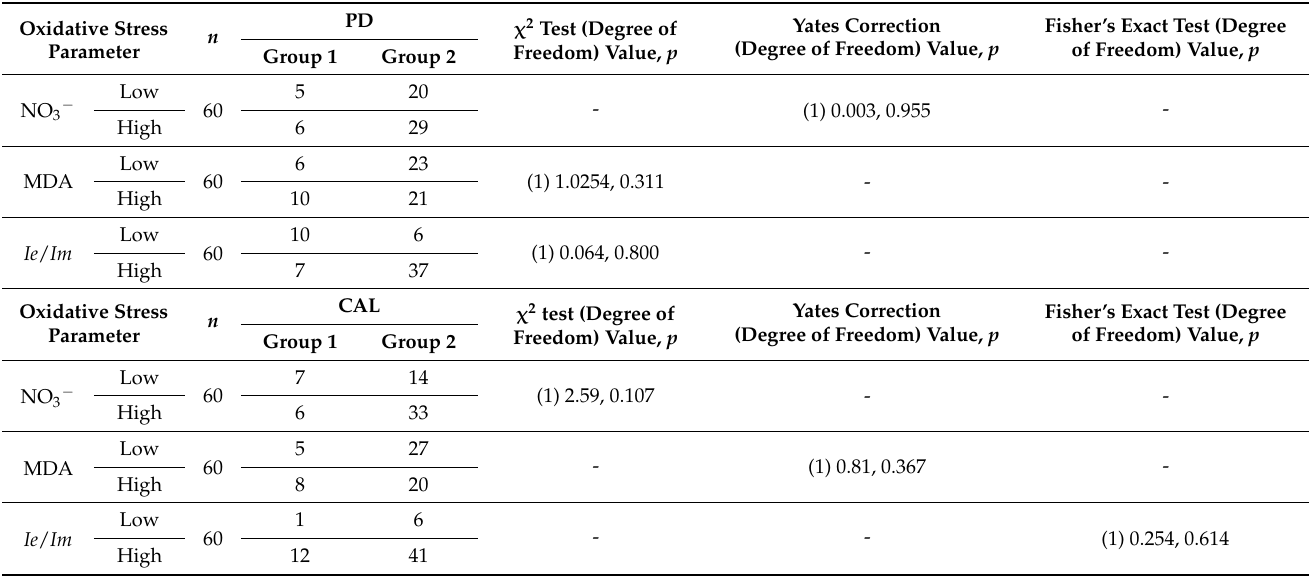
Table 4. Association of markers of oxidative stress with PD and CAL in patients with